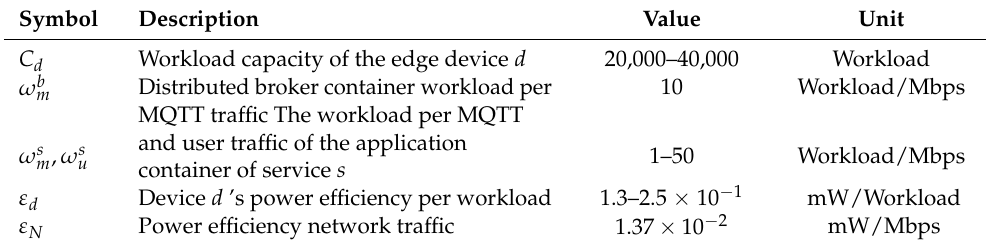
Table 3. Simulation parameters for container placement optimization.